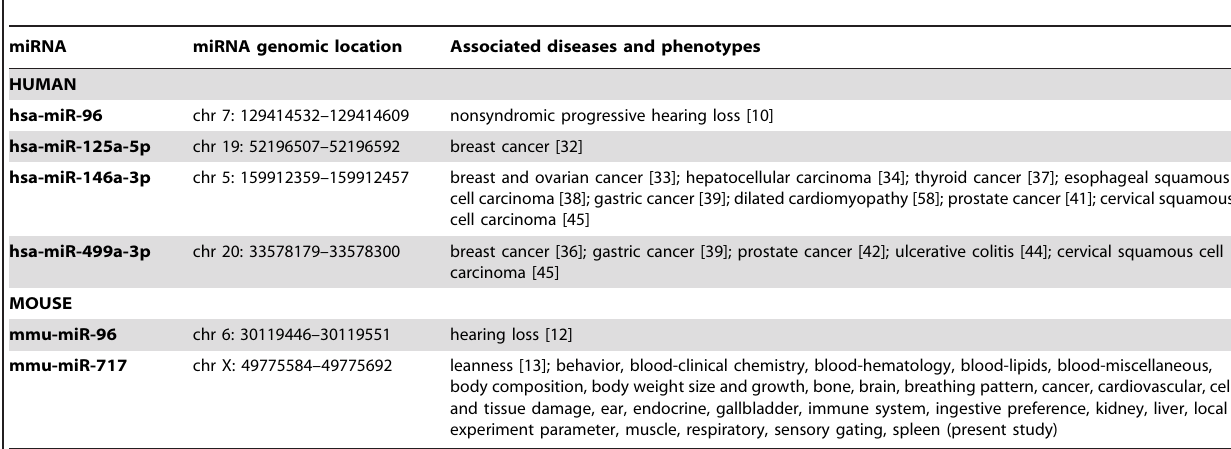
Table 1. Diseases and phenotypes associated with miRNA gene polymorphisms within the seed region in human and mouse.